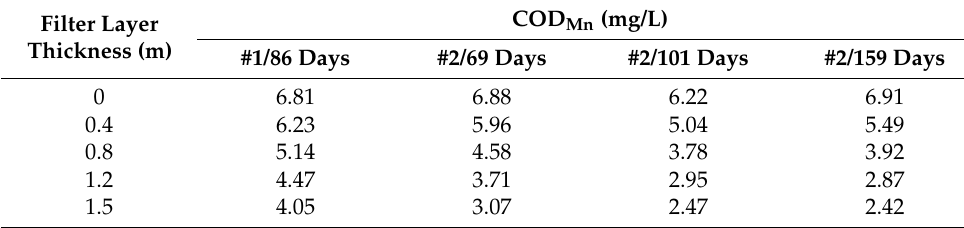
Table 2. Variations in COD Mn along the filter layer at different stages.